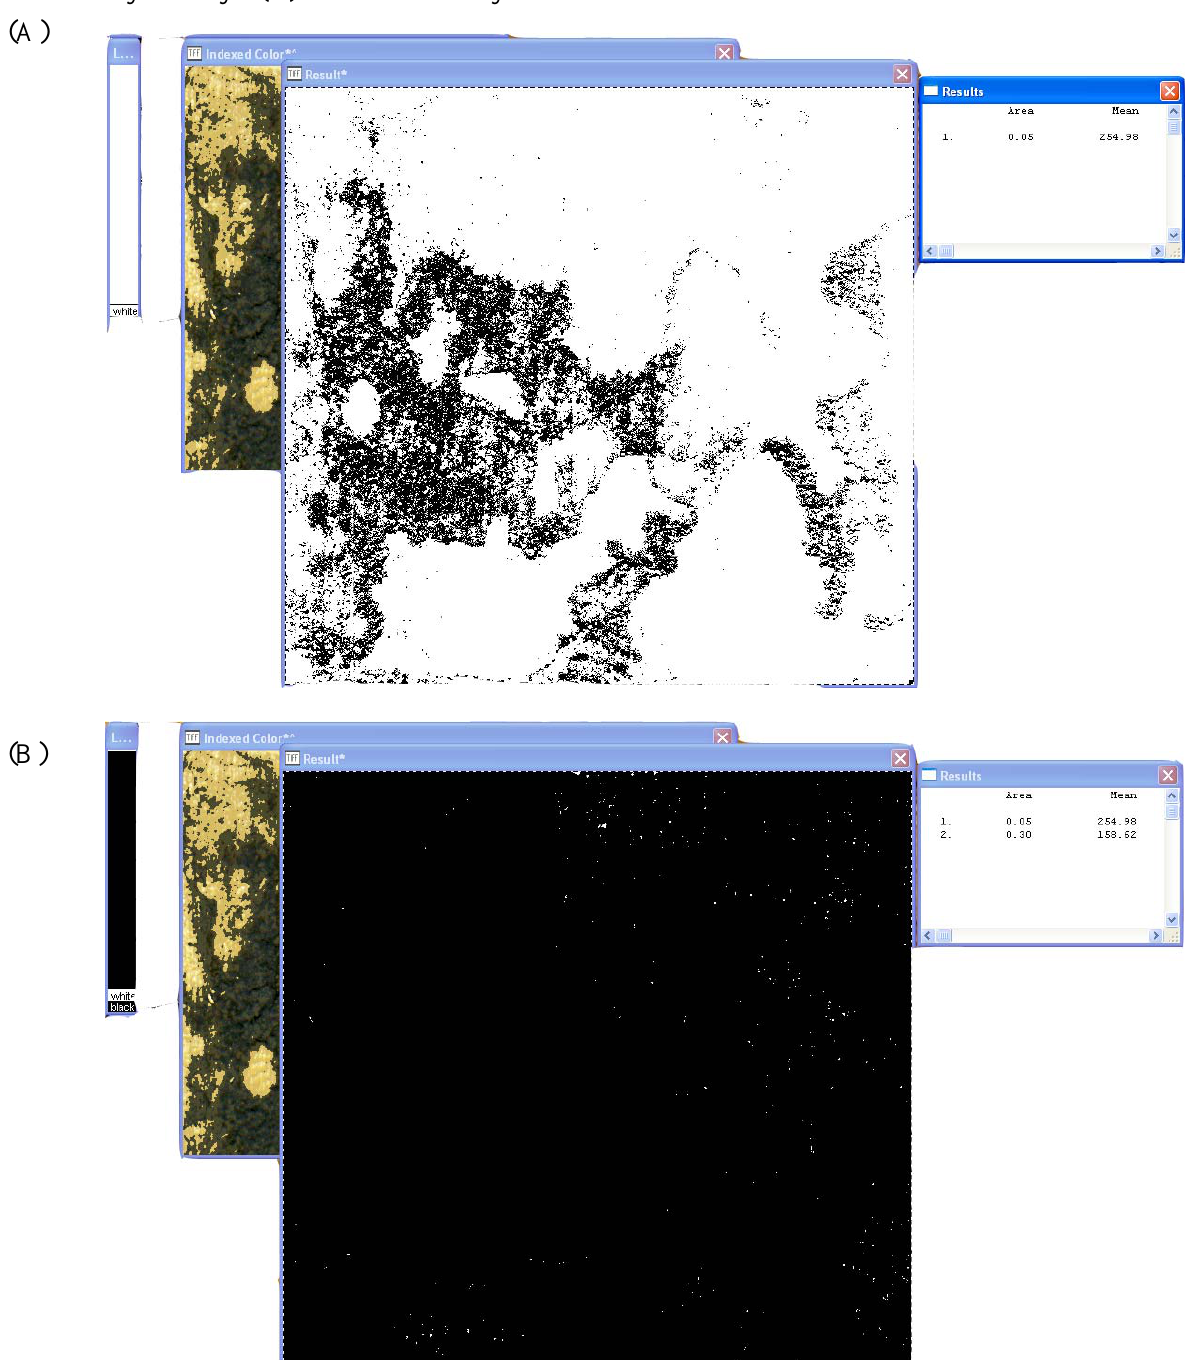
Figure 3 . Analysis of true black using threshold and the LUT